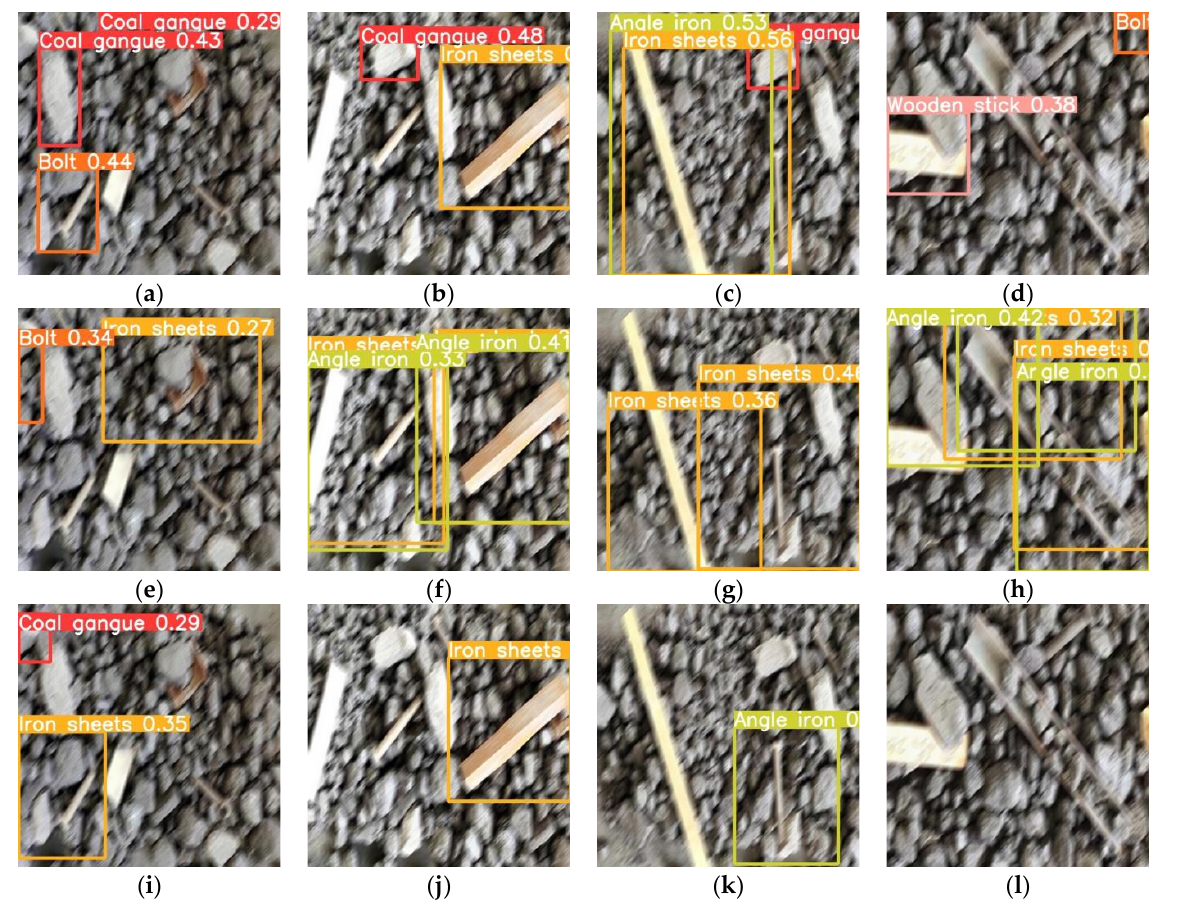
Figure 8. Detection results of blurred images before and after the improvement, ( a – d ) belong to the result achieved by the original Yolov5-s network, ( e – h ) are the detection results achieved by the improved network when the pruning rate is 0.8, and ( i – l ) are the detection results when the pruning rate is 0.9.